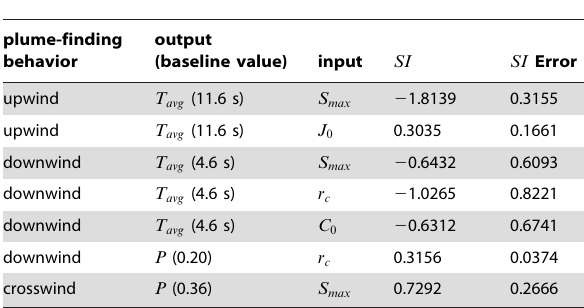
Table 2. Most sensitive local variation.